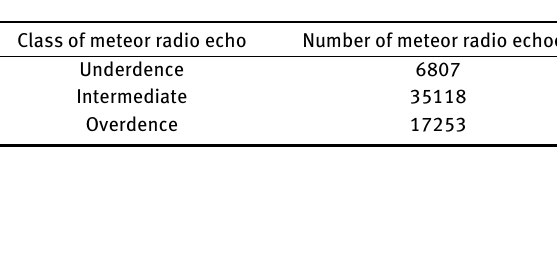
Table 3. The number of meteor radio reflections of various classes obtained using a classifier based on an artificial neural